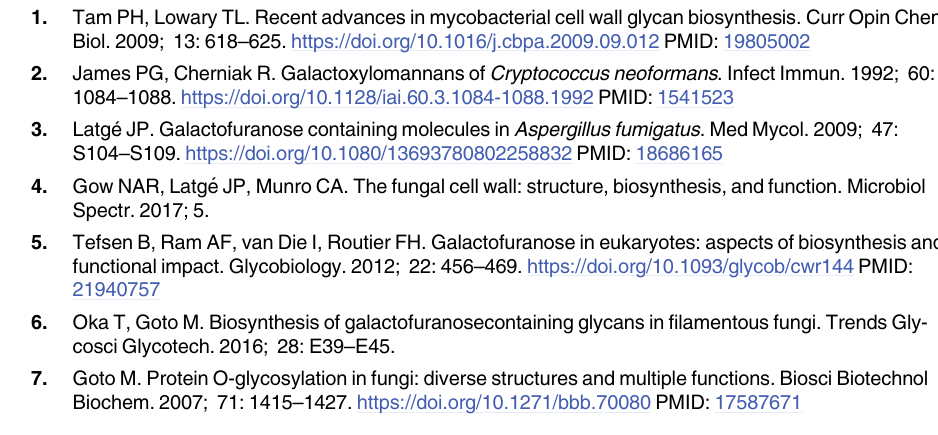
S3 Fig. Sensitivities of the mutant to cell wall stressors. A serial dilution of conidia of 1 × 10 4 − 1 × 10 1 of the WT, the mutant and complemented strain were inoculated on PDA agar plates supplemented with 40 μ g/ml calcofluor white or 40 μ g/ml Congo red. Strains were cul- tured at 28˚C. S1 Table. Oligonucleotides used in this